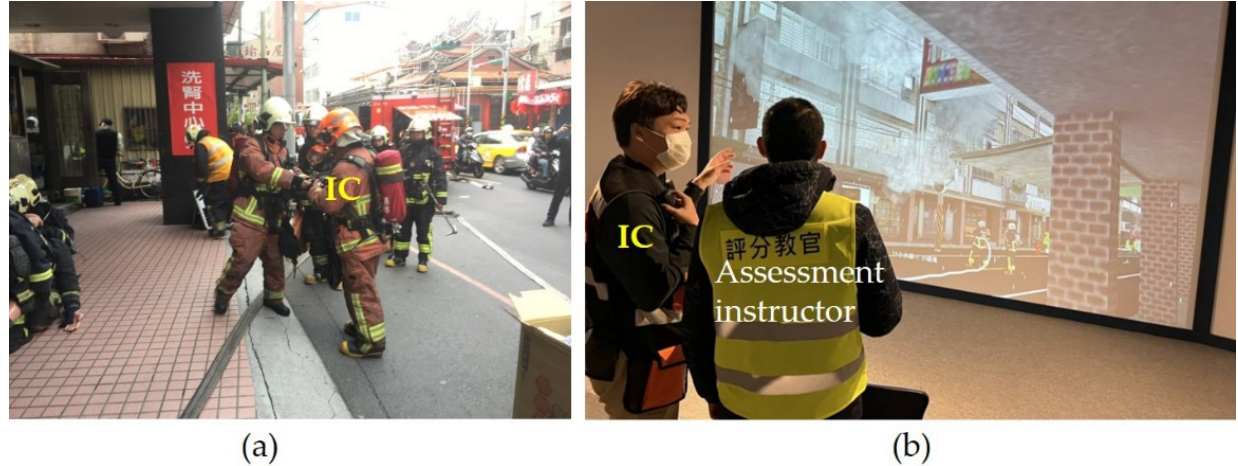
Figure 1. ( a ) For traditional training (LST), one IC trainee responds to the situation of live simulation training, assigning tasks to support units (one company officer and three firefighters). The scene is an operating building (not a training ground). There is no identifiable fire or smoke, and the simulated situation is only expressed through oral language. ( b ) In this study (VRST), one IC trainee responded to the VR situation and informed the assessment instructor about the task assignment.